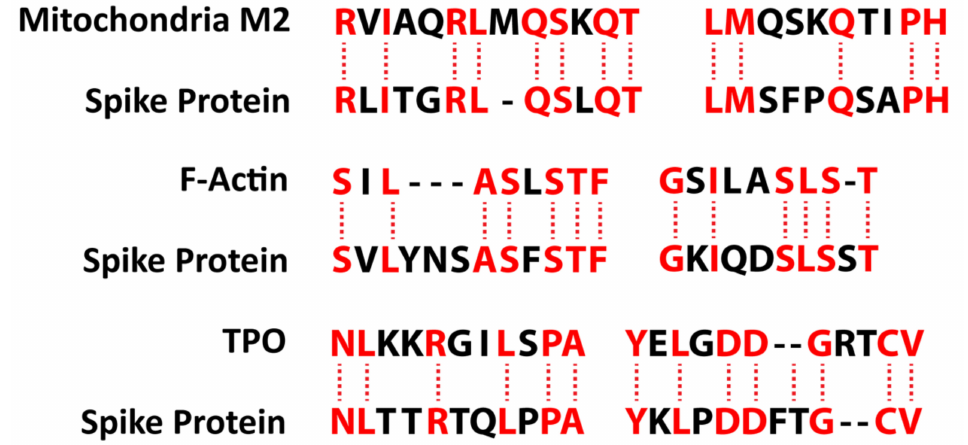
Figure 4. Peptide molecular mimicry between SARS-CoV-2 spike protein and mitochondria M2, F-actin, and thyroid peroxidase (TPO)